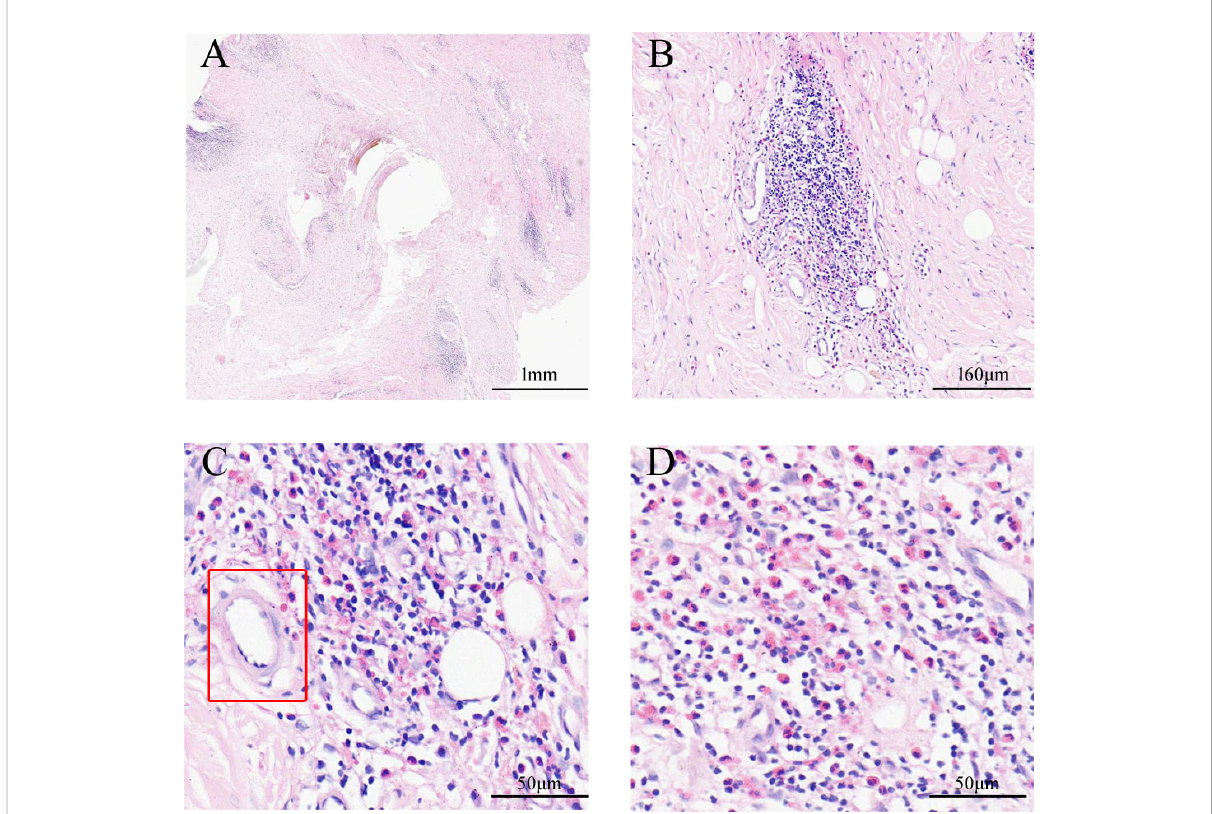
FIGURE 3 The pathological characteristics of ear masses. The gross view of pathological sections (A) . In the cortical region, lymphoid tissue hyperplasia with numerous eosinophils in fi ltrating (B) ; hyperplasia of postcapillary venules with hyalinosis (C, D) ; the marked region with the rectangle in C shows hyaline blood vessels (Hematoxylin and Eosin